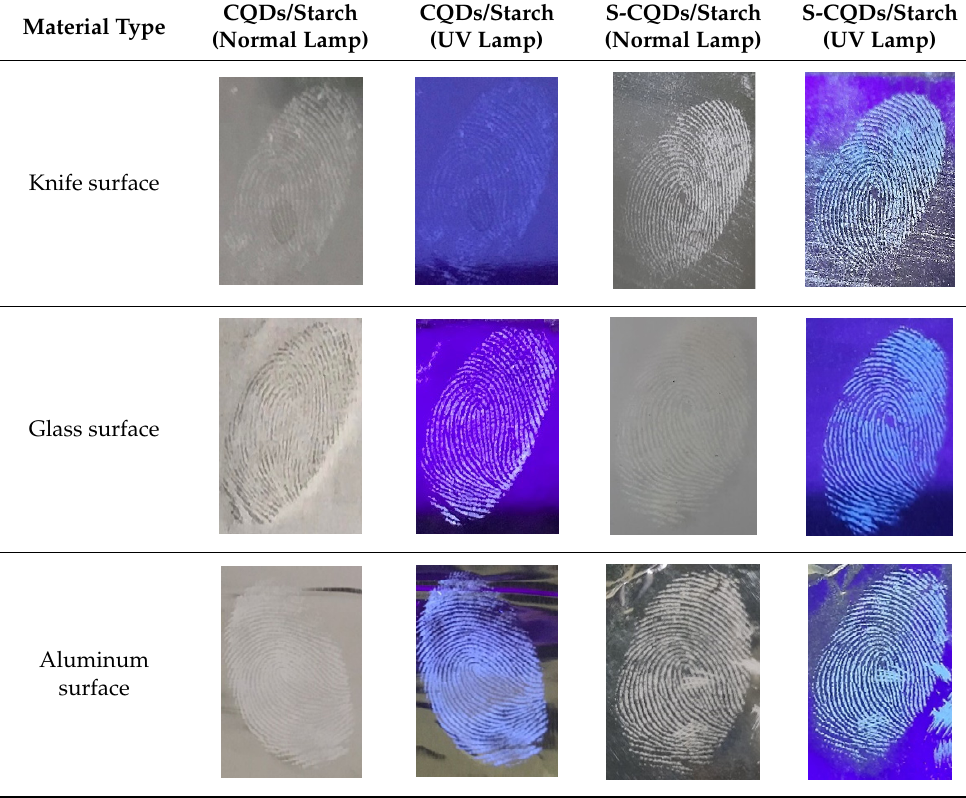
Table 2. Detection of latent fingerprints using different particle sizes of S-CQDs/corn starch under normal and UV lamps.